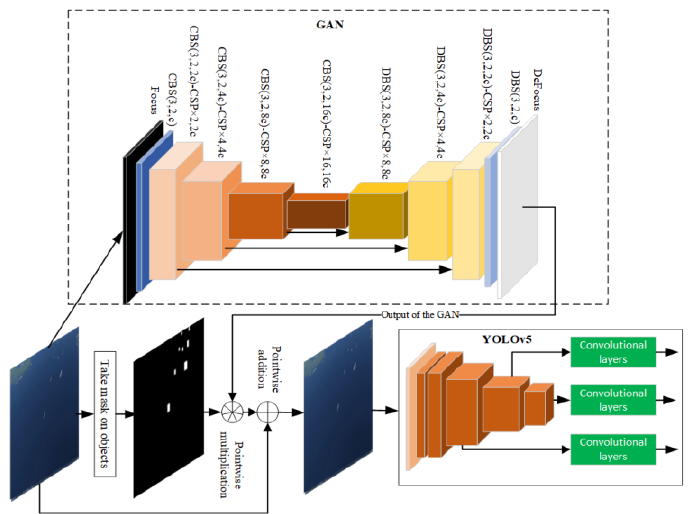
Figure 4. Adversarial noise-generating network. The main structure of the network is similar to the network of backbone plus patching image generator in Figure 2. The CBS, DCBS, and CSP modules are the same as those in Figure 2.